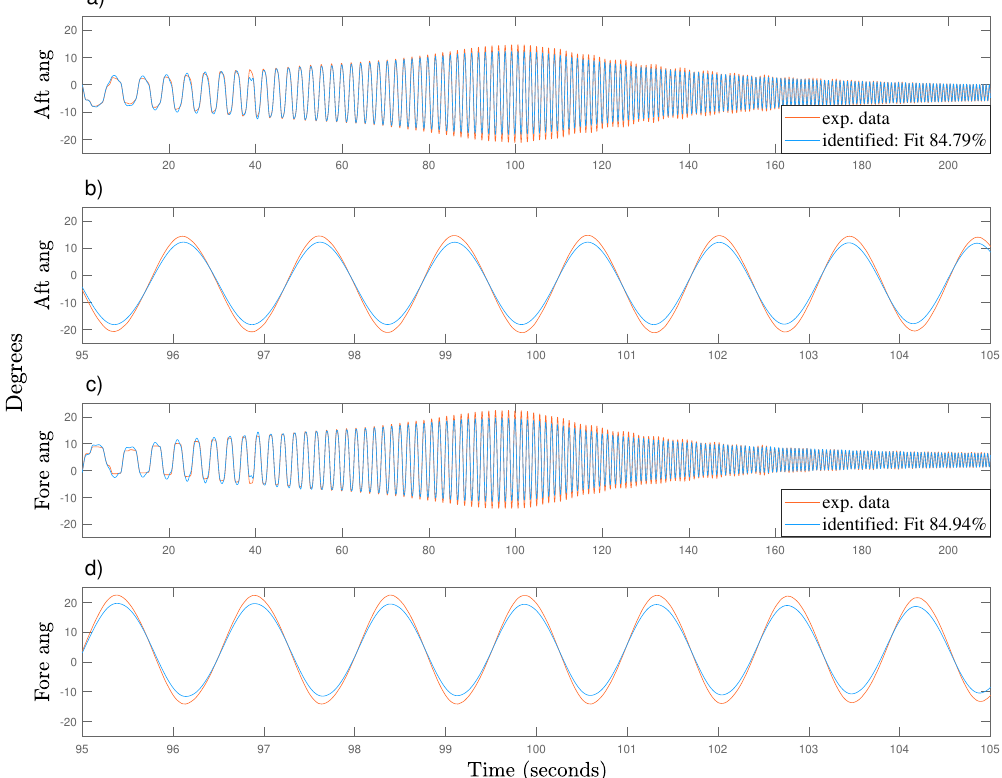
Figure 10. Comparison of modelled and experimental system using a input chirp signal with 69 N amplitude. ( a , c ) aft and fore angles, respectively. ( b , d ) zoom to the resonance part for aft and fore angles,